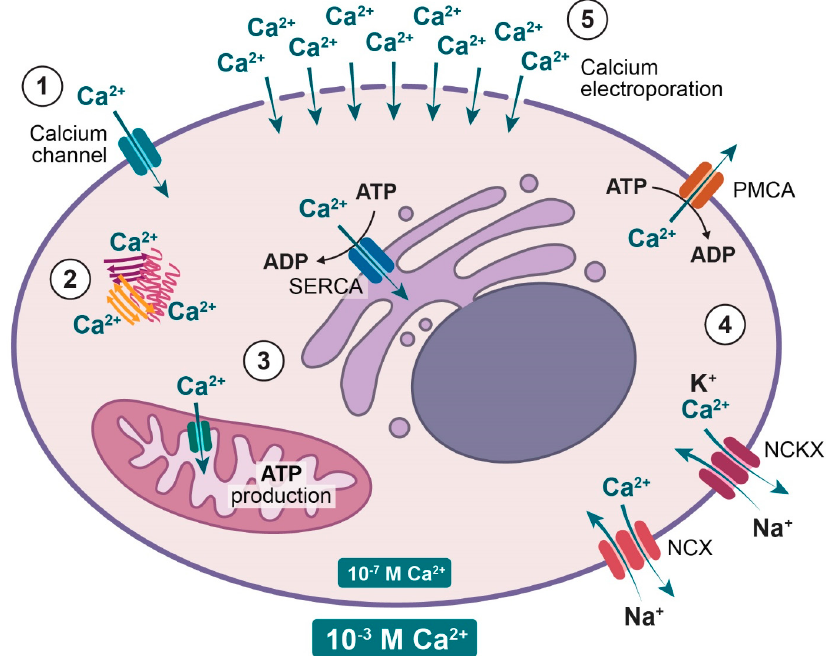
Figure 2. Cellular calcium homeostasis. Calcium is tightly regulated to maintain the low intracellular calcium concentration. ( 1 ) Calcium can enter the cell through calcium channels. ( 2 ) Inside the cells calcium is chelated by proteins. ( 3 ) Mitochondria and endoplasmic reticulum store calcium where transport is facilitated by transporters including the sarco-endoplasmic reticulum calcium ATPase (SERCA). ( 4 ) Calcium is extruded from the cell by the ATP dependent plasma membrane calcium ATPase (PMCA) and the sodium calcium exchanger (NCX) and the sodium calcium potassium exchanger (NCKX). ( 5 ) Calcium electroporation induces high intracellular concentrations of calcium by permeabilisation of the plasma membrane in the presence of high extracellular calcium concentrations.